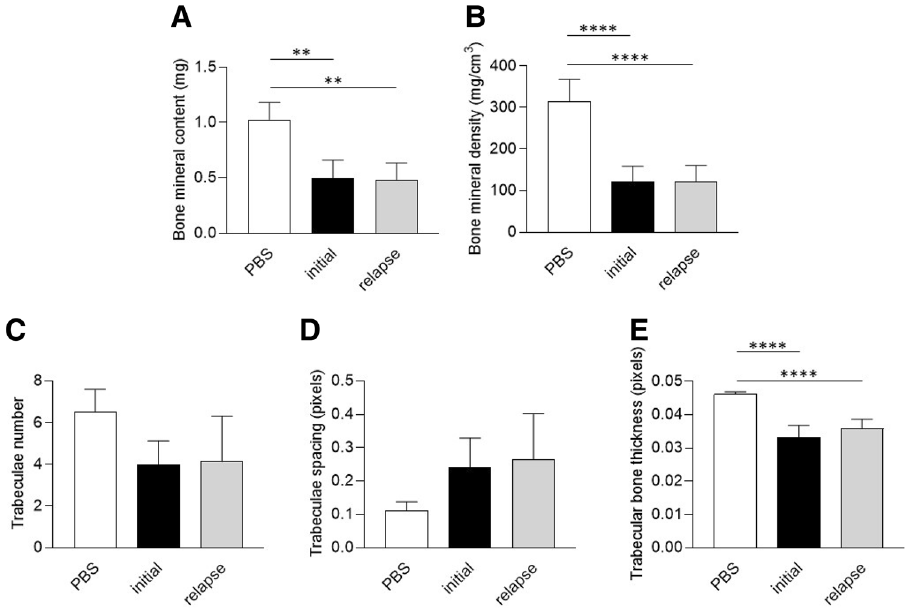
Figure 5. Effect of S. aureus clinical strains (initial and relapse) on the trabecular bone in vivo after 14 days of infection. A prolonged infection was performed for 14 days with the same conditions as in Fig. 1 (PBS, n = 3; Initial, n = 7; Relapse, n = 6). After microtomography and 3D reconstruction, the following parameters were quantified: bone mineral content in mg ( A ), bone mineral density in mg/cm3 ( B ), trabeculae number in the ROI ( C ), space between the trabeculae in pixels ( D ) and trabecular bone thickness in pixels ( E ). ** and **** mean P < 0.01 and P < 0.0001